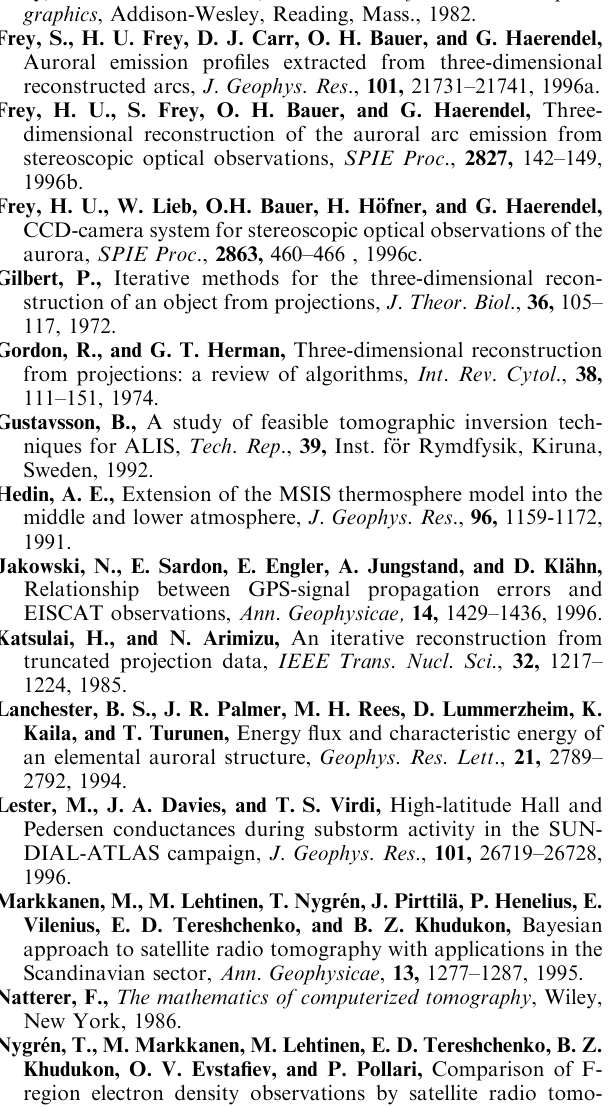
Fig. 8. Calculated height-integrated Hall ( left ) and Pedersen ( right ) conductances at 1836:30, 1837:53, 1838:10, and 1838:30 UT. The x - and y -axes correspond to the 60 (cid:2) 60 km 2 area of reconstruction and the z -axis shows the conductances in units